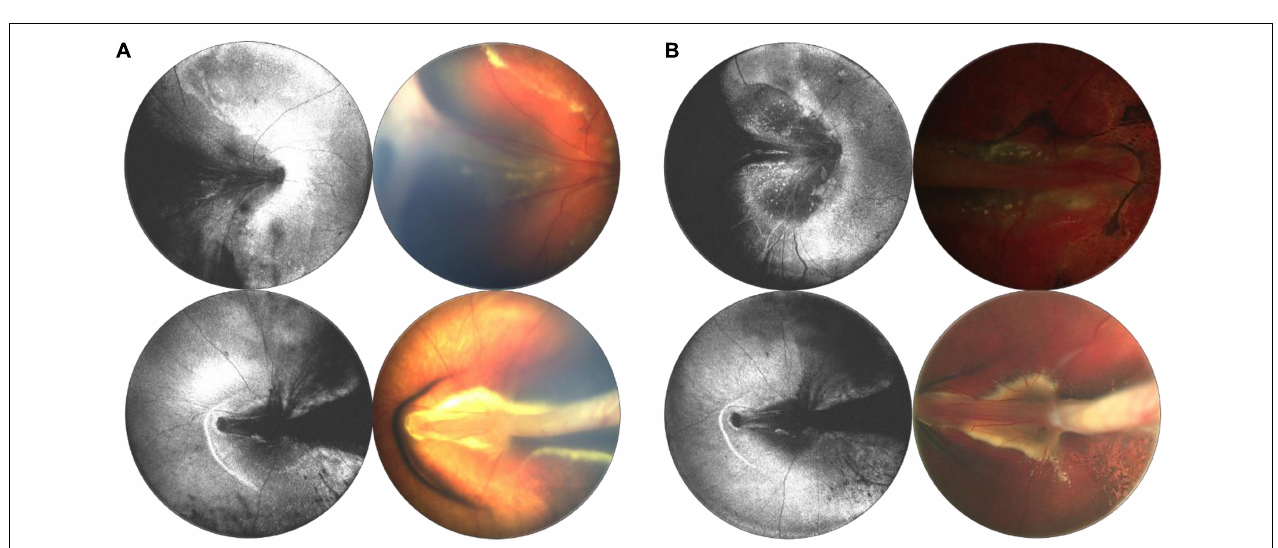
FIGURE 10 | Anterior segment (AS)-OCT. (A) AS-OCT in a 6-month-old with PFV. Leftmost en face OCT demonstrates good pupillary dilation and central cataract. Middle image shows en face of AS-OCT, with corresponding color-coded B-scans on the right. The scan outlined in yellow was taken at the limbus, providing visualization of the ciliary body. The scan outlined in purple shows the iris, with a reflection artifact affecting the cornea. (B) Silicone oil in the anterior chamber on AS-OCT in a 14-year-old. Leftmost image shows three-dimensional rendering of the iris and anterior chamber, while rightmost image shows a close up of retained oil above the lens. Both (A,B) were captured with a 105 ◦ FOV.